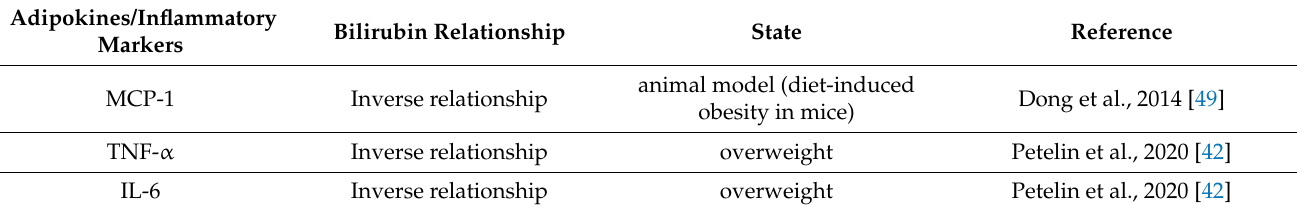
Table 1. Adipokines and inflammatory markers that are altered in obese and overweight individuals and relationships with serum bilirubin